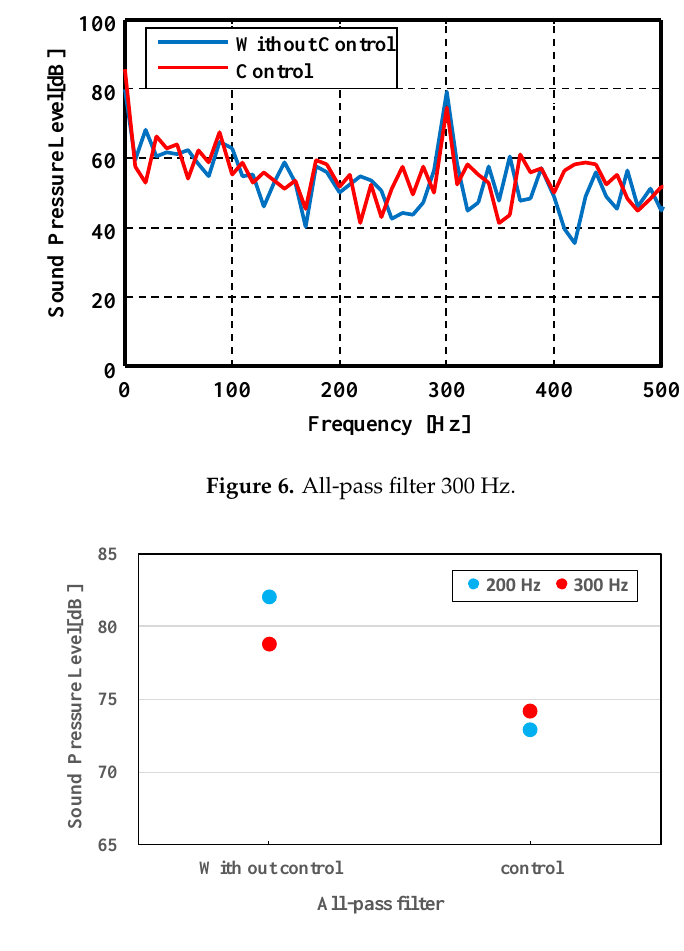
Figure 7. Experimental result of All ‐ pass filter.